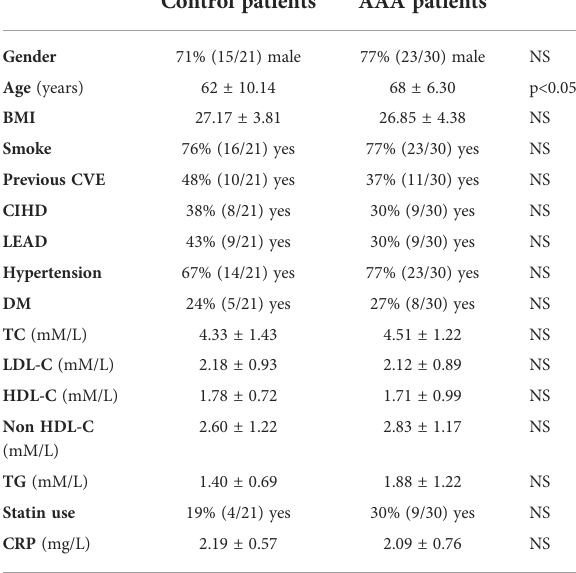
TABLE 1 Clinical and biochemical parameters of control and AAA